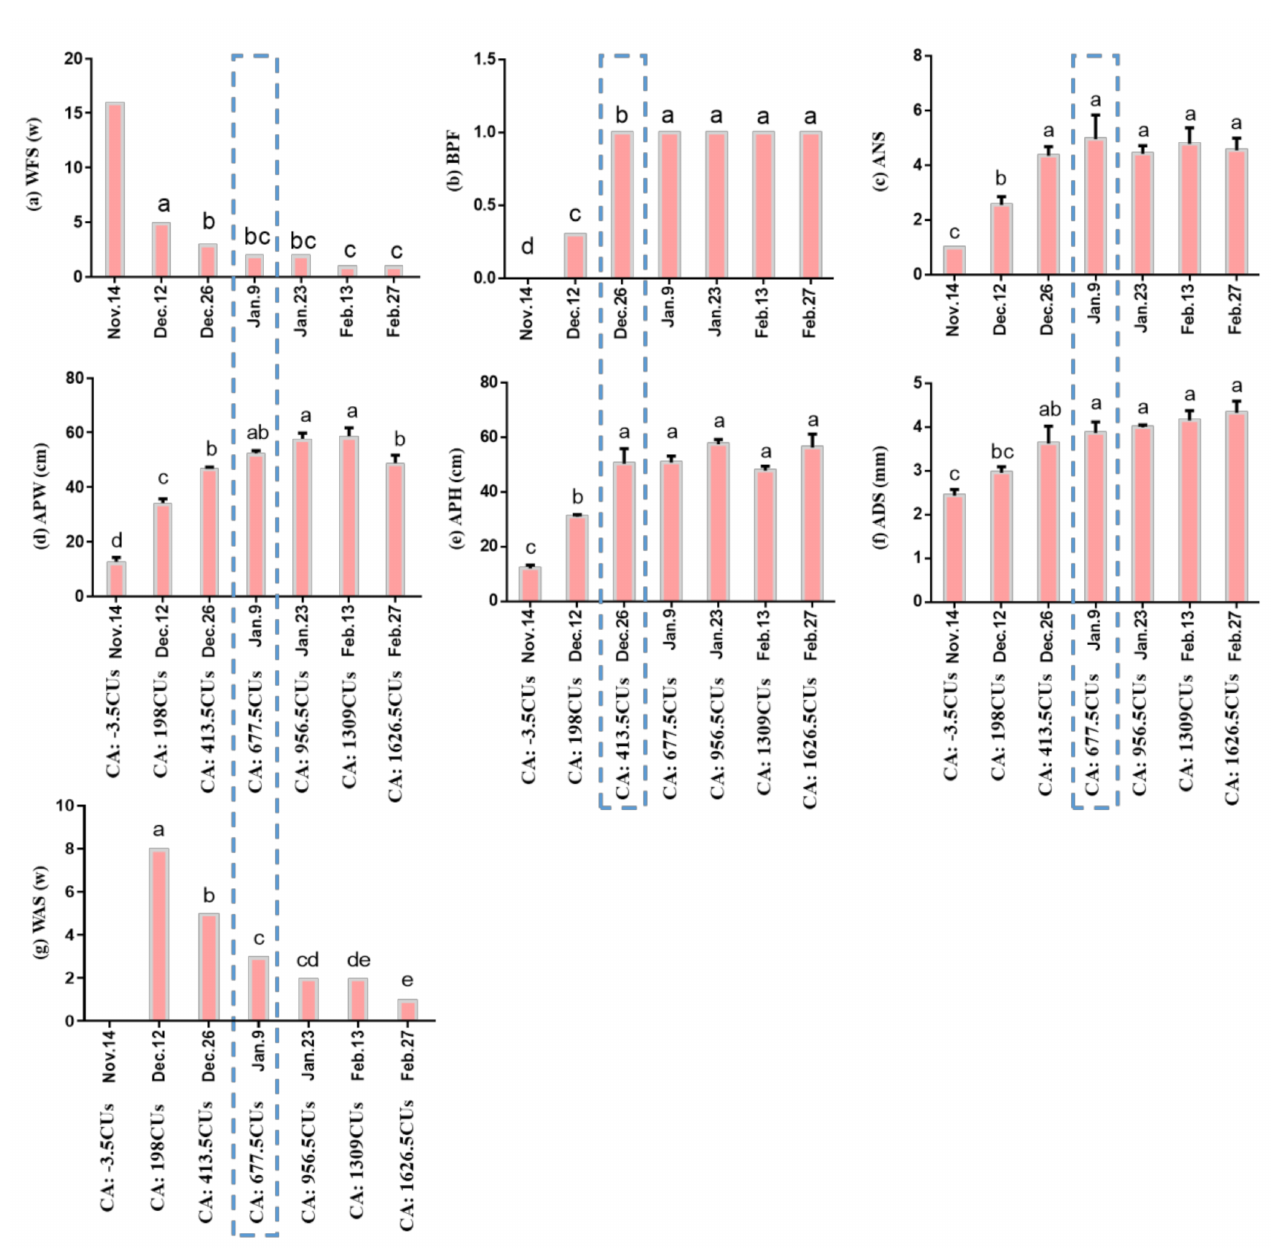
Figure 3. Sprouting and regrowth of the ‘Meiju’ plants transferred to the greenhouse on different dates (with different natural chilling accumulations). The blue dashed frames indicate the dates at which the change in morphological indices became sufficiently stable. (a) WFS: Number of weeks until the first plant sprouted in the glasshouse; (b) BPF: Bud break percentage five weeks after the potted crowns were moved to the glasshouse; (c) ANS: Average number of mature and normal stems during the full-flowering period; (d) APW: Average plant width during the full-flowering period; (e) APH: Average plant height during the full-flowering period; (f) ADS: Average diameter of stems during the full-flowering period; (g) WAS: the number of weeks until all plants sprouted in the glasshouse. Different letters indicate a significant difference among different dates ( p <